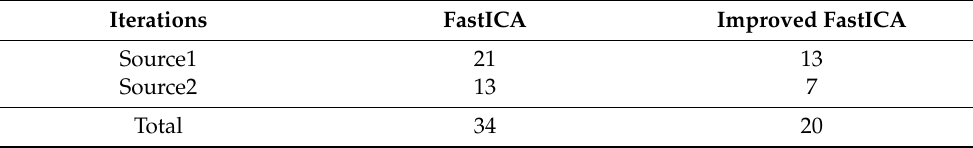
Table 3. The number of iterations corresponding to the separated two source signals in a certain